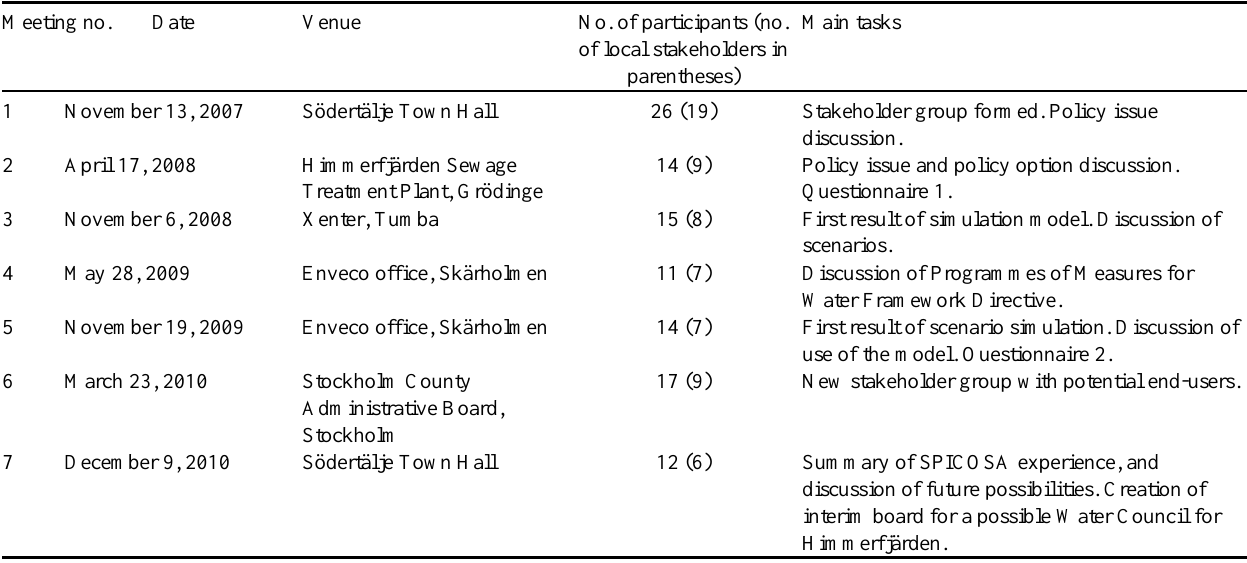
Table 4 . Stakeholder group meetings during the research process. The participants were the members of the study site team and local